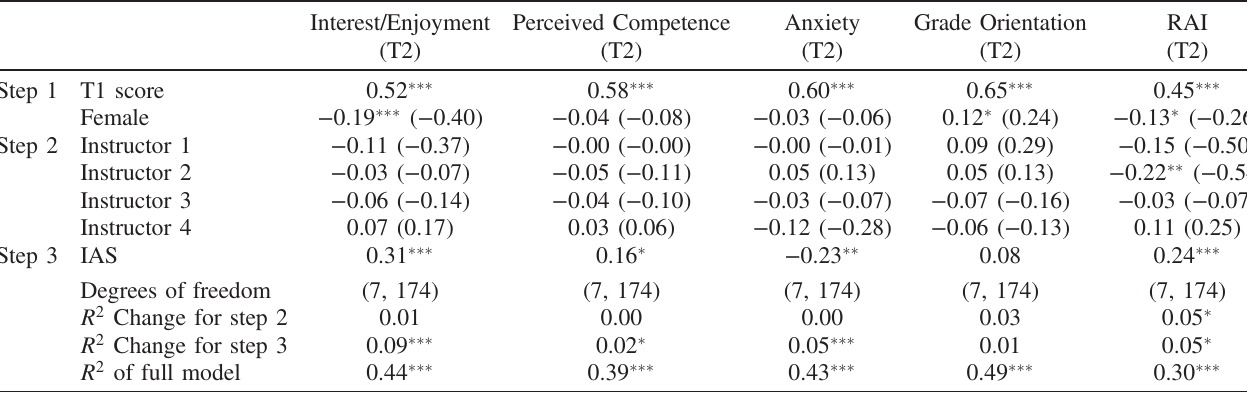
TABLE V. Regressions of each dependent variable (Interest/Enjoyment, Perceived Competence, Anxiety, Grade Orientation, and relative autonomous reasons for studying physics) at the end of the course (T2) onto the score at the beginning of the course to create a change score and Female (step 1), instructor variables (step 2), and instructor autonomy support as perceived by the students (step 3). Standardized correlation coefficients ( β ’ s) are given with accompanying p values, where (cid:2) p < 0 . 05 , (cid:2)(cid:2) p < 0 . 01 , (cid:2)(cid:2)(cid:2) p < 0 . 001 . For the dummy independent variables (Female and the instructor variables), the coefficients when only the dependent variables were ’ s) are also given in parenthesis. The degrees of freedom, R 2 changes, and R 2 of the full model are also given for each standardized ( β DV model. We see that students who perceived their instructors as more autonomy supportive tended to become significantly more interested in learning physics and less anxious about taking physics and came to study physics for more autonomous reasons (i.e., more because they wanted to versus had to) ( N ¼ 182